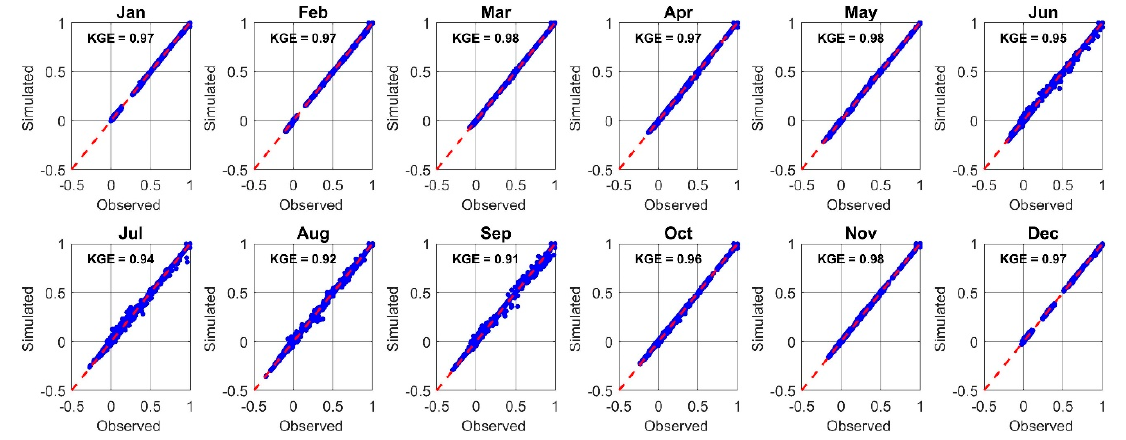
Figure 9. Spatial and cross correlation comparison of the daily weather variables for each month.